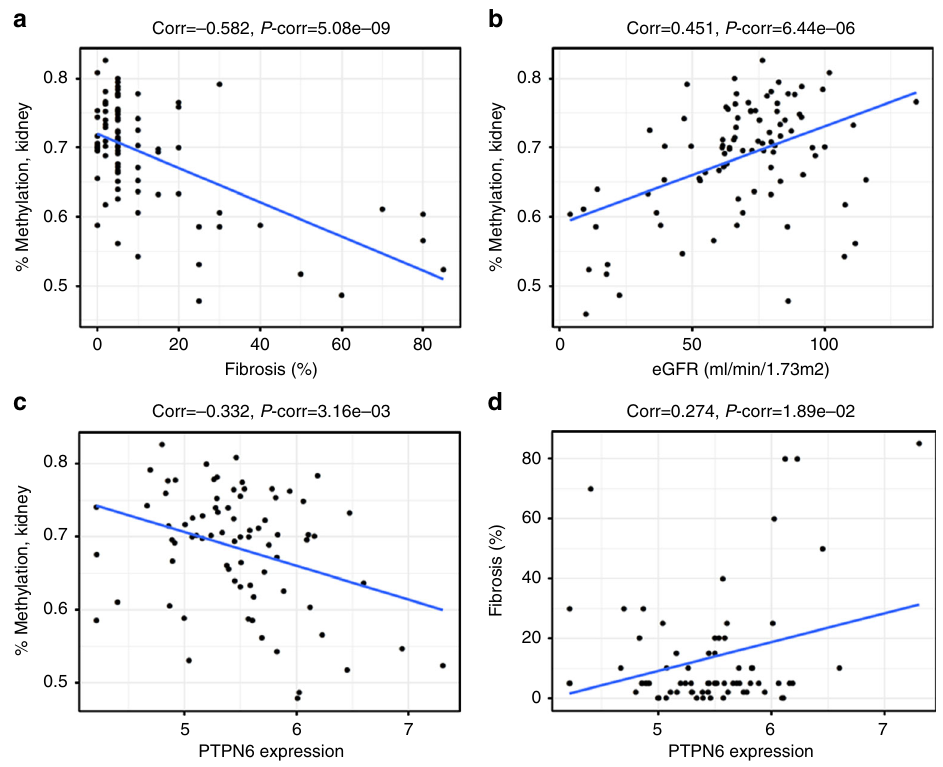
Fig. 3 Association between DNA methylation of cg19942083 at PTPN6 / PHB2 in kidney tissue and renal fi brosis, eGFR, and gene expression. DNA methylation was quanti fi ed from 95 kidney tissue samples. Higher DNA methylation at cg19942083 on chromosome 12 is correlated with lower % fi brosis ( P = 5.1e-09, a ) and higher eGFR ( P = 6.4e-06, b ) in patients with CKD, indicating less tissue damage and better kidney function. Of the two genes adjacent to the CpG, PTPN6 and PHB2 , higher DNA methylation in kidney was associated with lower transcript levels of PTPN6 ( P = 3.2e-03, c ). Supporting the direction of observations A-C, higher PTPN6 transcript levels were associated with higher % fi